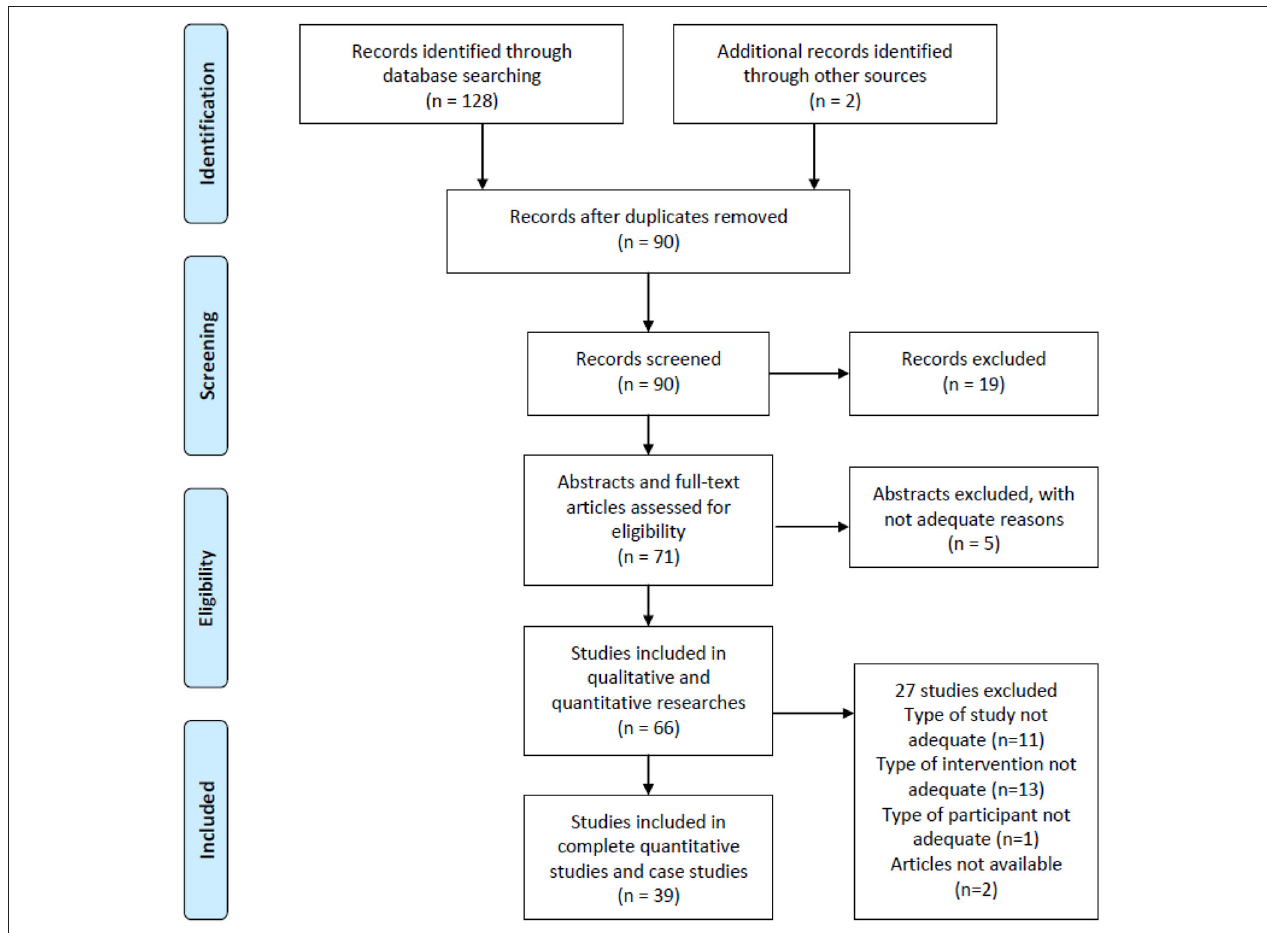
FIGURE 1 | Flow diagram of article identification and